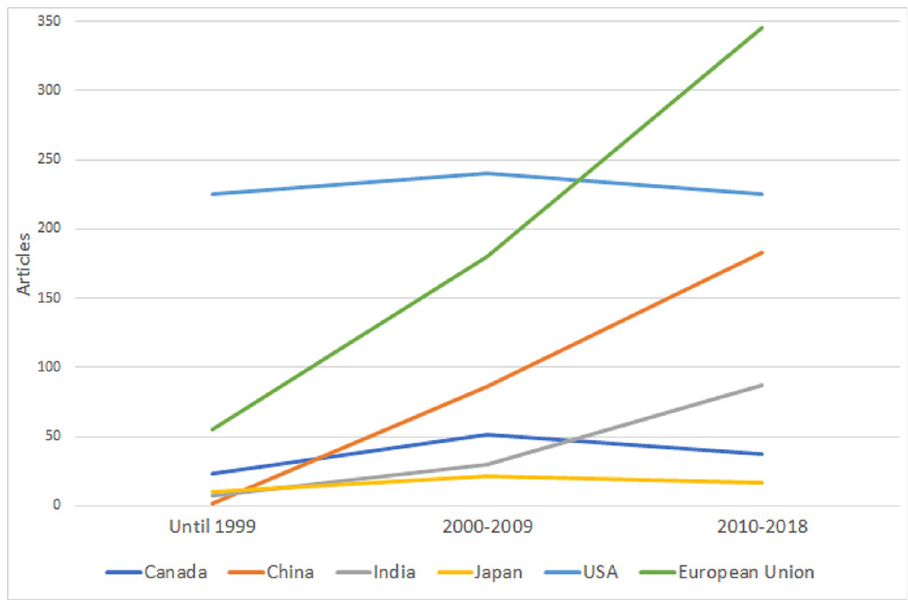
Fig 1. Evolution of published articles in the field of biocontrol using Bacillus thuringiensis strains. The vertical axis represents the number of articles published in each of the 3 periods analyzed (until 1999, 2000–2009, and 2010–2018) by country (Canada, China, Japan, and the USA) or regulatory region (European